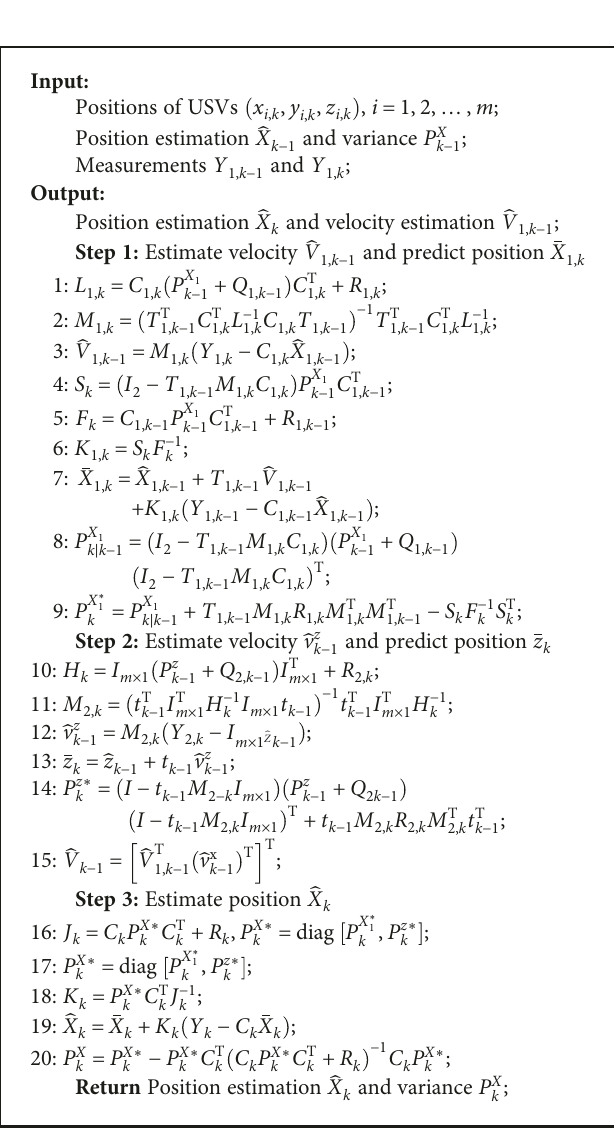
Algorithm 1: Framework of three-step SISE